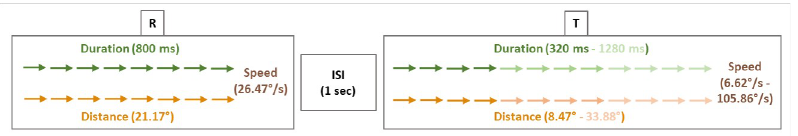
Fig 1. Illustration of a trial: The reference sound (R) moved at the fixed speed of 26.47˚/s, the target sound (T) at faster or slower speeds according to the manipulation of the reference distance and/or duration. R and T were always separated by 1 second interstimulus interval